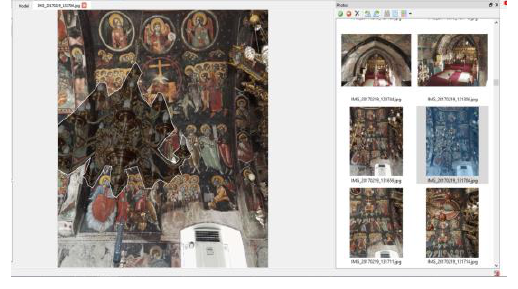
Figure 8. Photomasking step